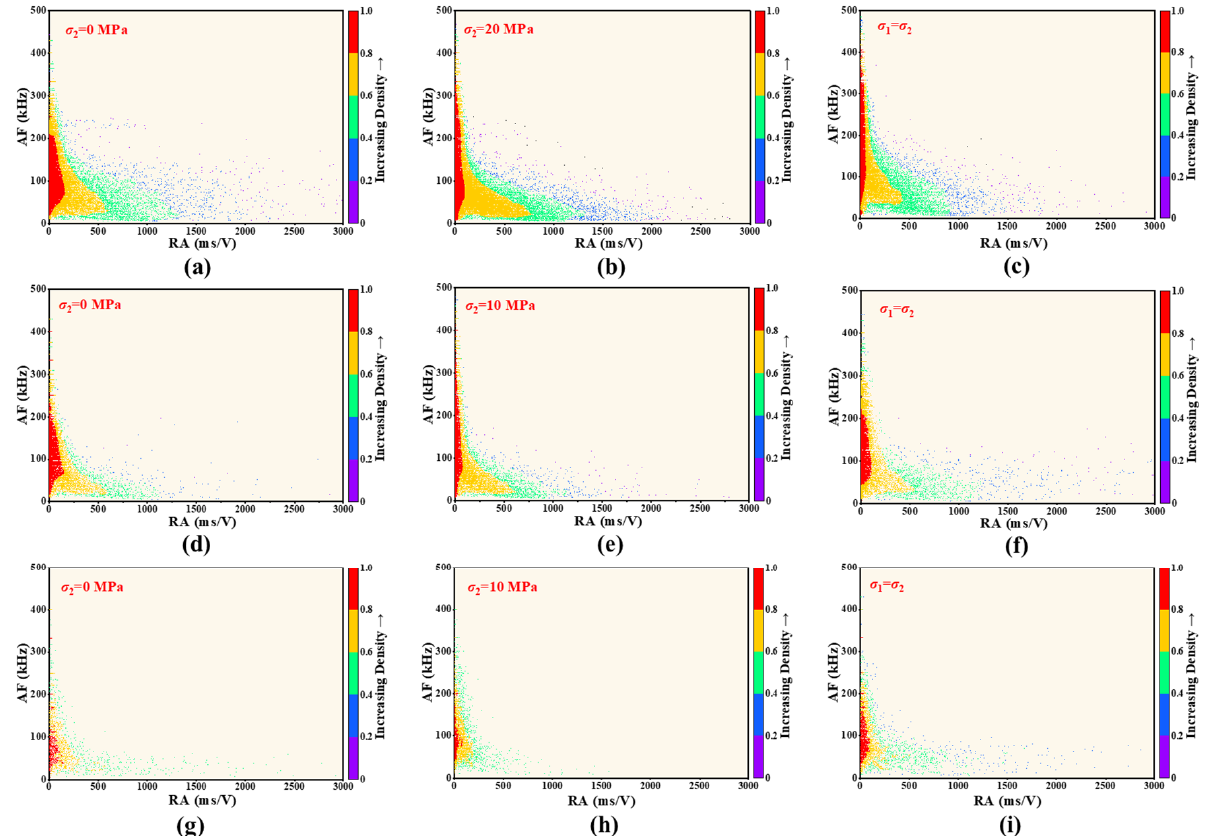
Figure 10. AF-RA dot density diagrams: ( a – c ) granite; ( d – f ) marble; ( g – i ) sandstone.